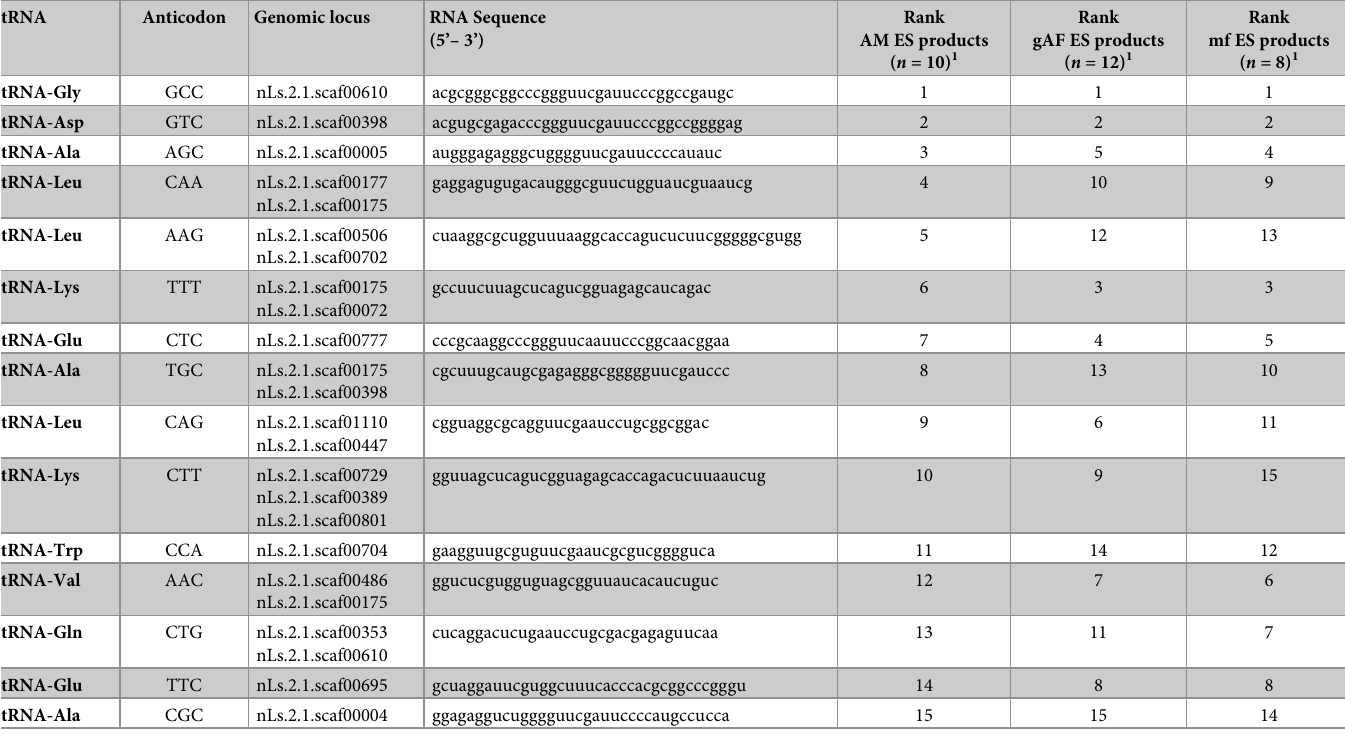
The 5’-derived tRNA fragments reported here are those with a relative abundance of > 1,000 RPM. 1 The median of the sequencing reads of the top most abundant 5’-derived tRNA fragments in the ES products of adult males (AM), gravid adult females (gAF), and microfilariae (mf) was used to determine the ranked